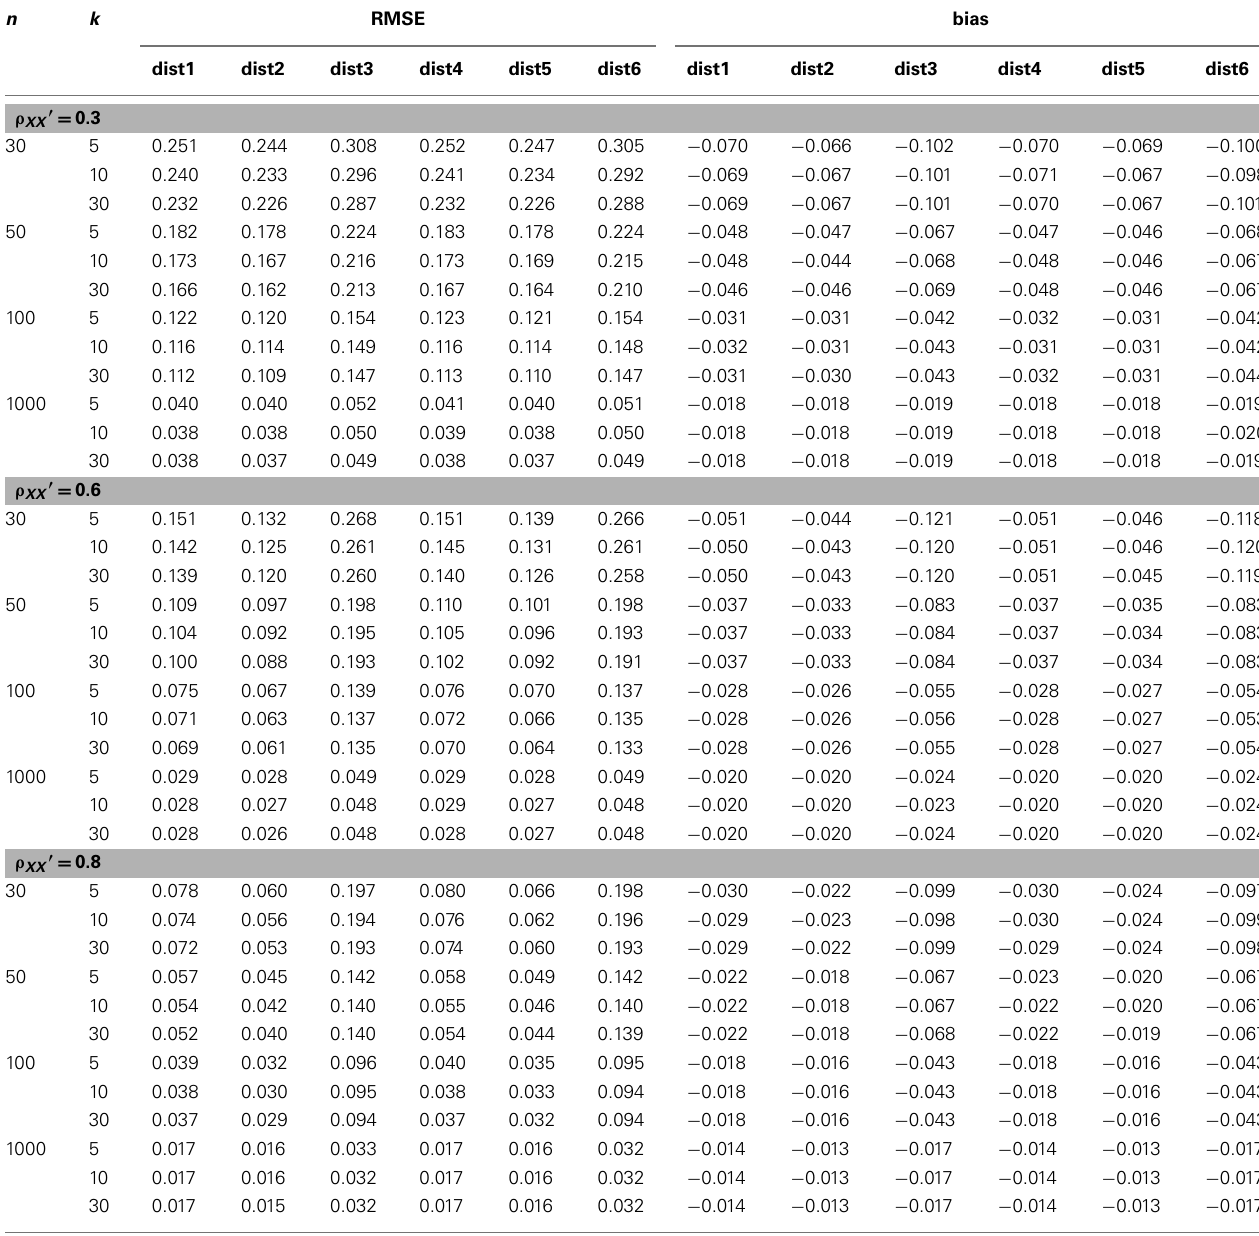
Table 2 | Root mean square error and bias for estimating α for the simulated situations where the true score ( t i ) distribution is normal or